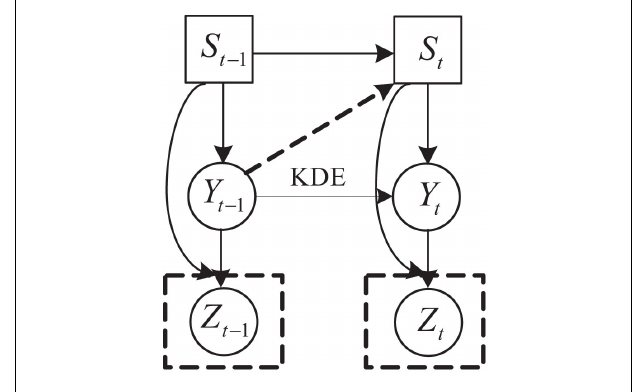
FIGURE 3 | Examples of two flexion traces.